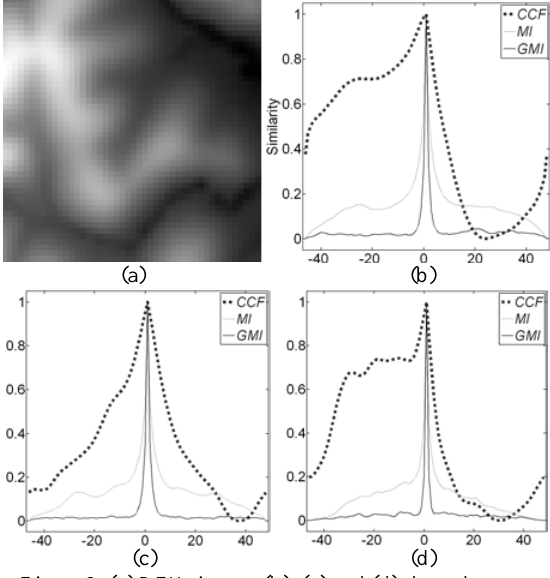
Figure 3. (a) DEM image; (b) ,(c) and (d) show the trace of CCF, MI and GMI functions while translations are applied along the x, y and diagonal